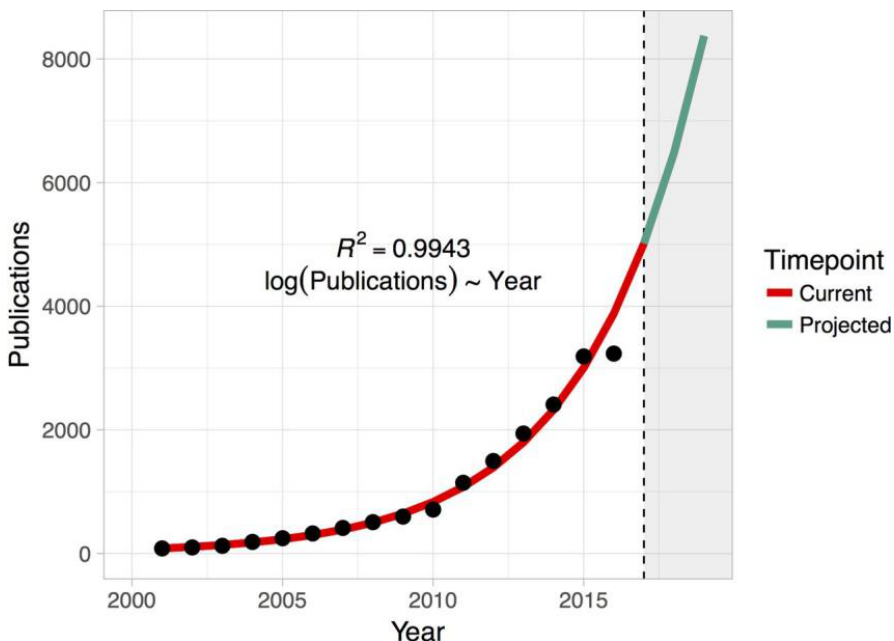
Figure 1. Projecting the growth of publications in PubMed ‘machine learning’. Exponentiated regression of log number of publications on year is used to predict the future trend (adapted from Shameer et al. [3]).